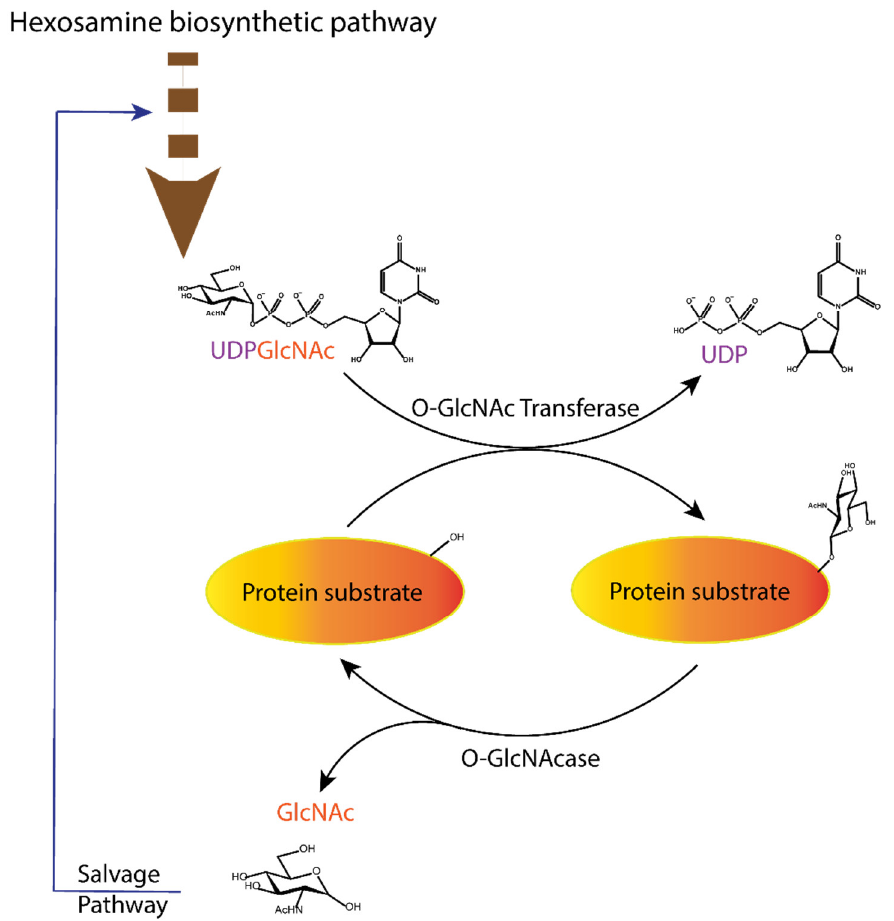
Figure 1. Dynamic equilibrium of the O-GlcNAcylation process. UDP-GlcNAc with the sugar moiety attached via α- O -glycosidic bond to the UDP is produced in the hexosamine biosynthetic pathway and subsequently attached to serine/threonine of protein substrates by O -GlcNAc transferase (OGT) via O -β-glycosidic bond. It is removed by O -GlcNAcase (OGA), and the GlcNAc formed after the OGA reaction re-enters the hexosamine pathway .